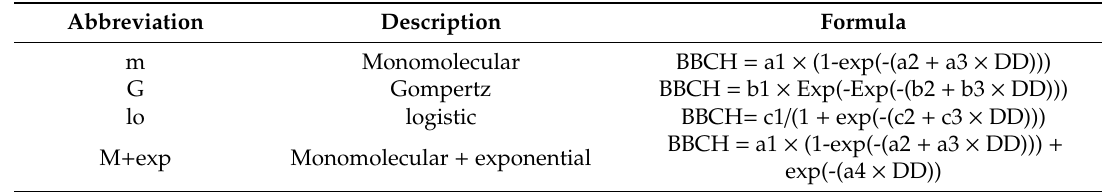
Table 2. Models used for predicting oilseed rape